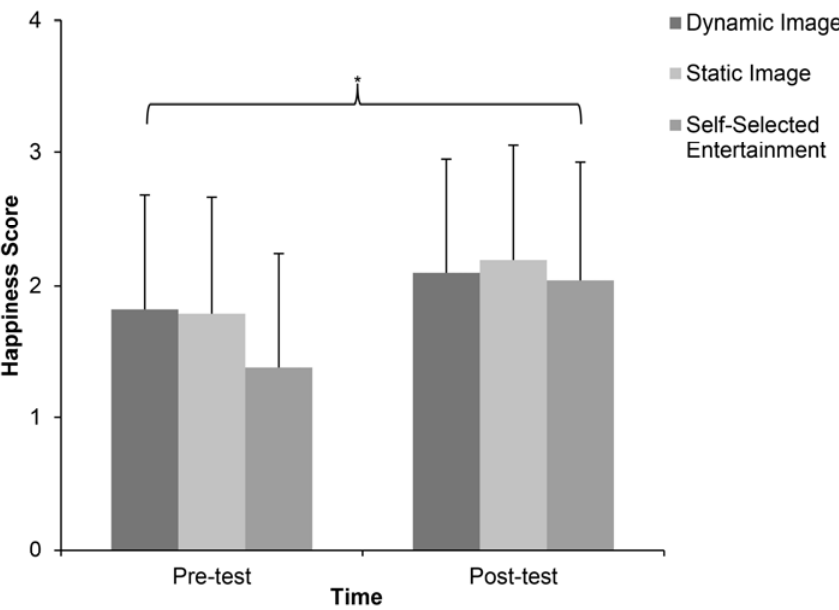
Figure 3. Pre-and-post scores on happiness scale in three conditions (mean ± SD). * indicating the time effect, p < 0.05.